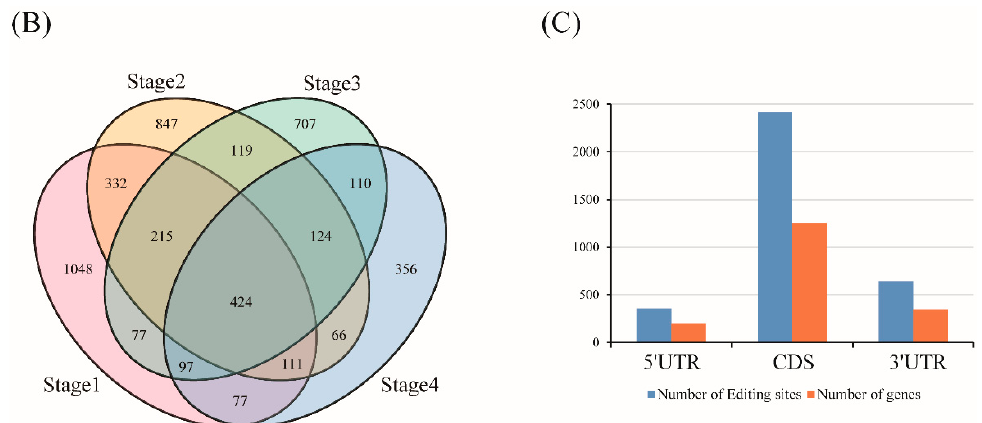
Figure 4. Identification of the RNA editing events during barley grain development. ( A ) The frequency of different types of nucleotide editing at four stages of barley grain development. ( B ) Venn diagram analysis of the abundance of RNA editing events among four stages of barley grain development. ( C ) The localization of RNA editing events in genic regions.